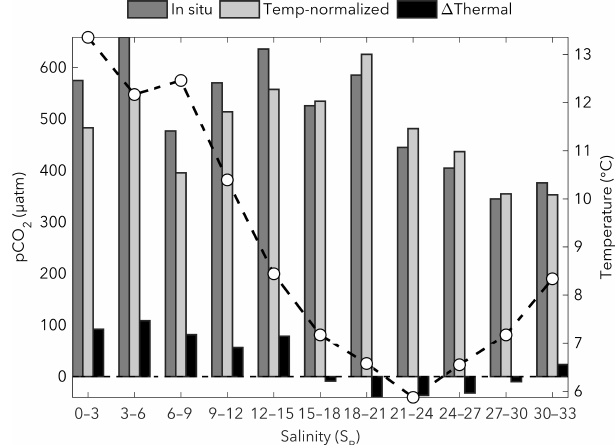
Figure 6. Surface-water in situ p CO 2 , temperature-normalized p CO 2 , and (cid:49)p CO 2 (temp) averaged over salinity bins of 3. The open circles show the average temperature for each salinity bin. To correct for the increasing or decreasing effect of temperature on surface-water p CO 2 , the in situ p CO 2 values were normal- ized to the average surface-water temperature of the study area ( T = 7 . 82 ◦ C). The (cid:49)p CO 2 (temp) values are the thermally induced p CO 2 changes due to temperature deviations from T = 7 . 82 ◦ C, whereas variations in temperature-normalized p CO 2 are due to wa- ter mass mixing and/or biological